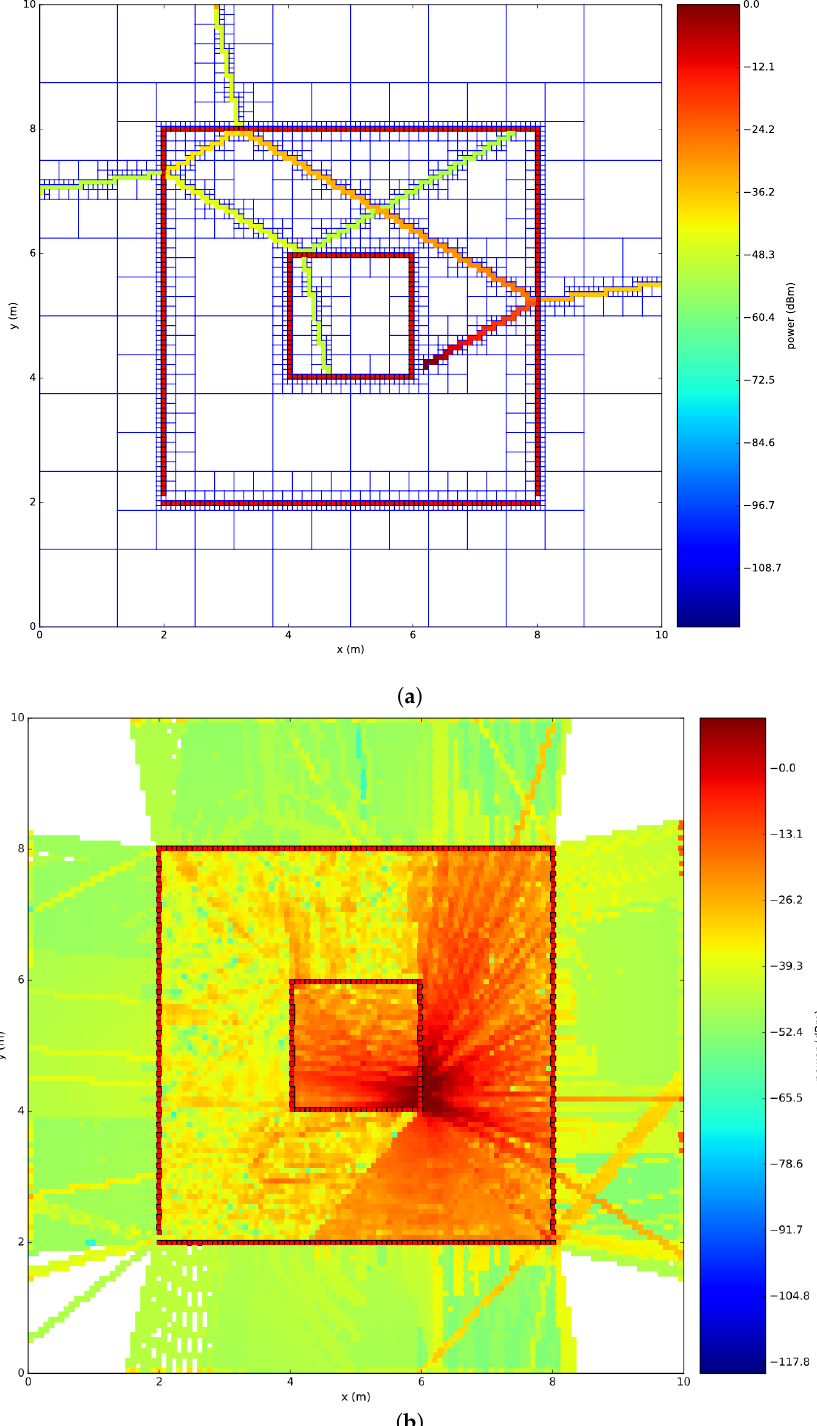
Figure 10. Example single ray propagation. ( a ) one ray; ( b )example of 1000